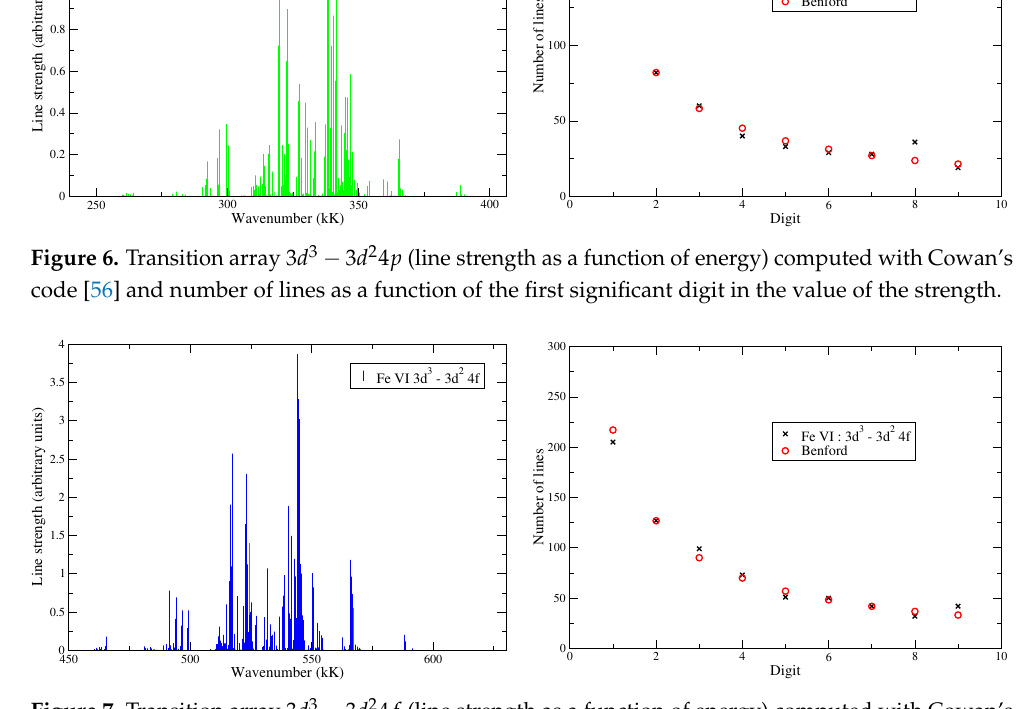
3 d 2 4 f (line strength as a function of energy) computed with Cowan’s Figure 7. Transition array 3 d 3 − code [56] and number of lines as a function of the first significant digit in the value of the